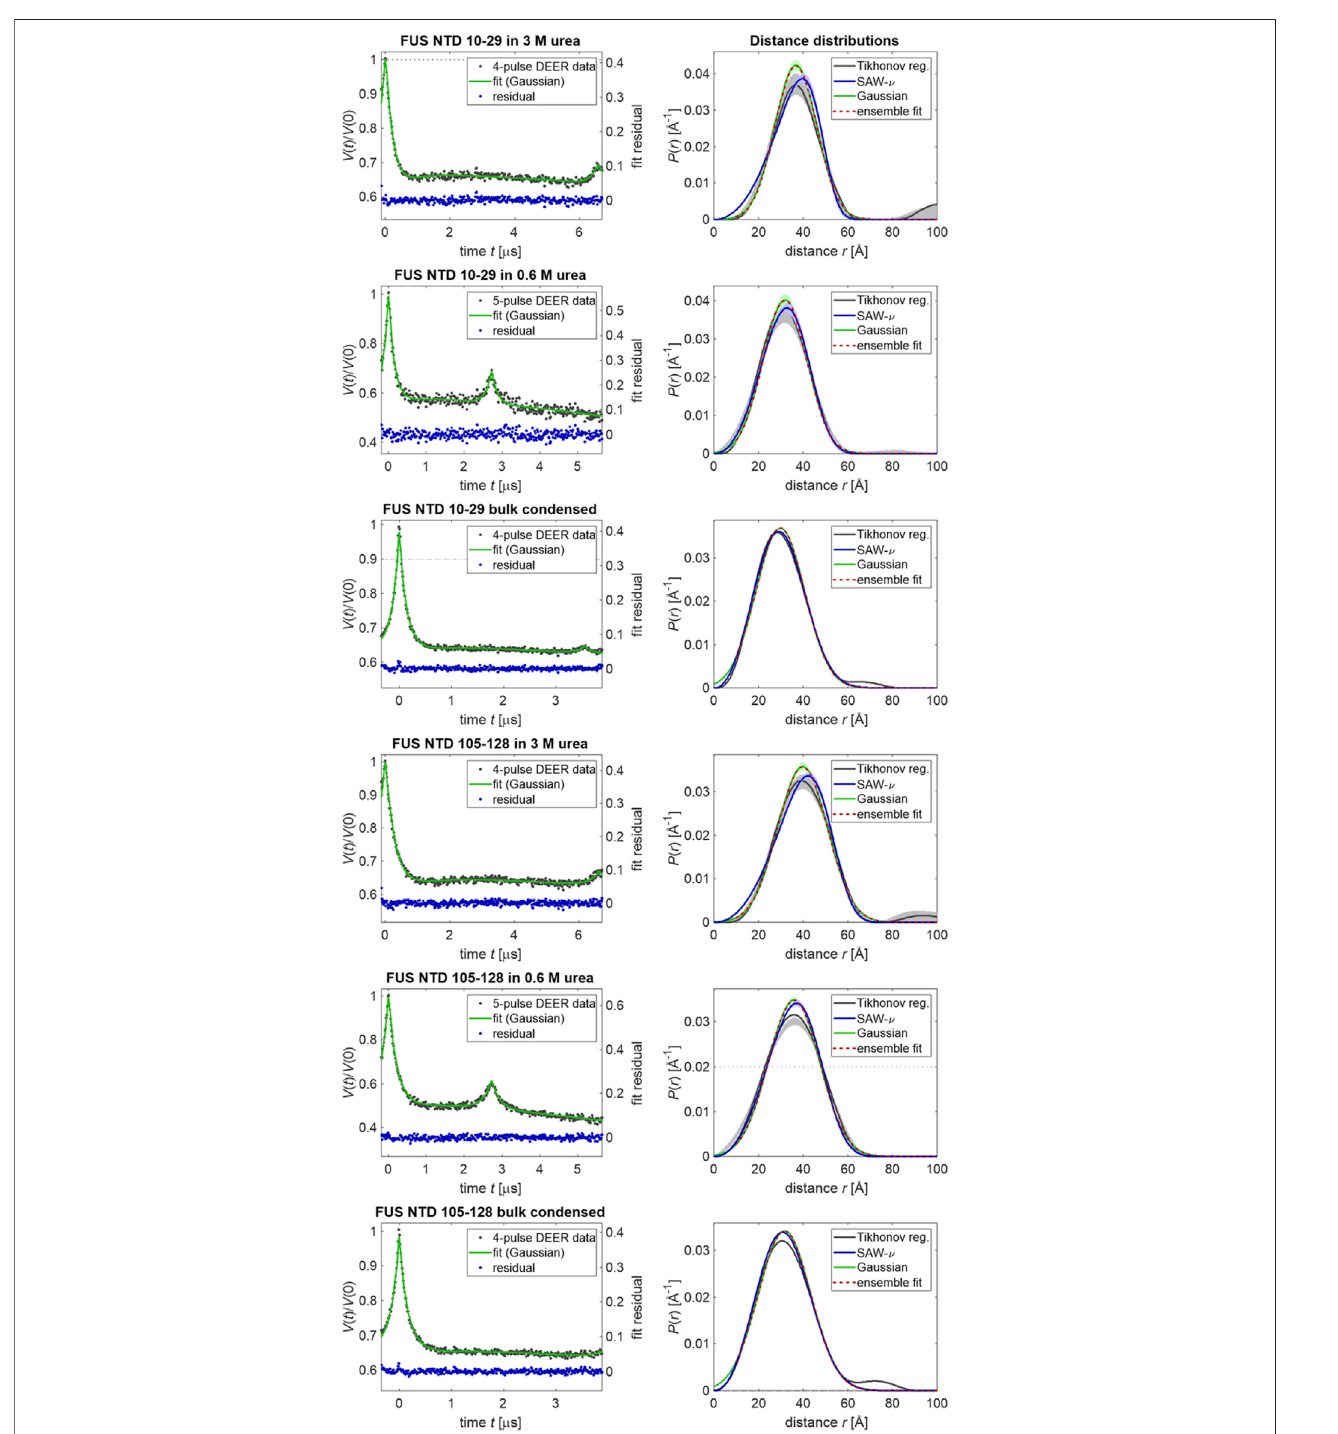
FIGURE 2 | Distance distribution measurements of sections delimited by spin labeling sites (10 – 29 or 105 – 128) measured with FUS NTD 1 – 267. The left column shows primary data (black dots), their DeerLab fi t by a single Gaussian distribution (green, left ordinate) and the fi t residual (blue dots, right ordinate). Signals from minor pathways at the end of 4-pulse DEER data or at the middle of 5-pulse DEER data were included in the kernel (Fabregas Ibáñez et al., 2020). The right column shows distance distributions obtained by Tikhonov regularization with choice of the regularization parameter by the Bayesian information criterion or residual method (black with gray uncertainty band), by single-Gaussian fi tting (green with pale green uncertainty bands) and ensemble fi ts of the Gaussian distribution (red) from raw ensembles of 2,500 conformers each.